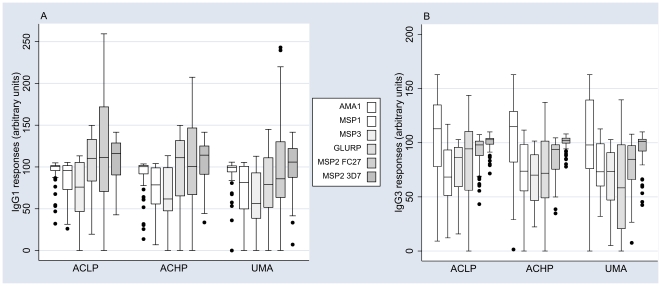
IgG antibody isotype responses in groups of children with and without malaria attacks.IgG1 (A) and IgG3 (B) responses to a panel of recombinant proteins corresponding to 5 different P. falciparum asexual stage antigens in groups of children segregated according to their status as either low (ACLP, <2500 parasites/ul) or high (ACHP, ≥2500 parasites/ul) asymptomatic parasitemia carriers, or those with one or more malaria attacks (UMA, parasitemia plus fever) during 12 months' follow-up. Box-whisker plots represent medians with 25th and 75th percentiles (boxes), and with 10th and 90th percentiles (whiskers), outliers as discrete dots.